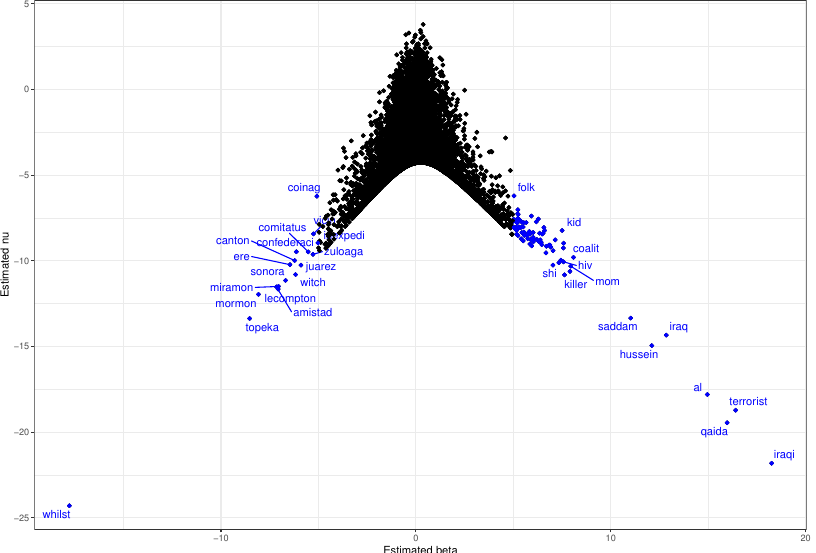
Figure 5. Estimated word positions from Wordfish .